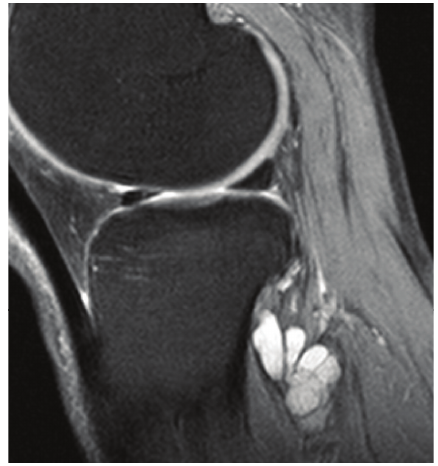
Figure 5: Multiple cysts within the popliteus muscle. Sagittal proton fat-saturated MR image of the right knee without e ff usion or synovitis in a 56-year-old male floor layer. The lesions represent an abnormal extension of the popliteus tendon synovial